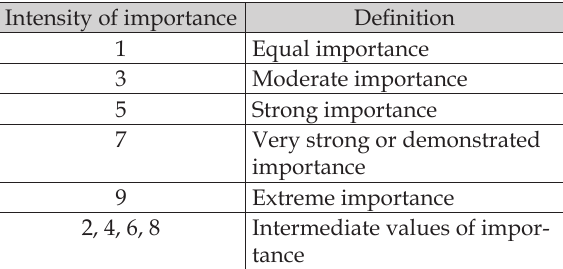
Table 5. Scale of AHP (Saaty